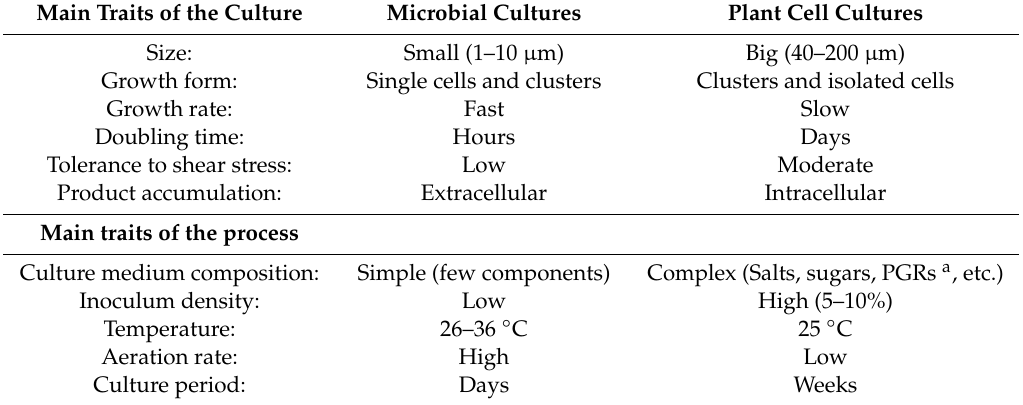
Table 4. The main di ff erences between biotechnological processes based on microorganism and plant cell